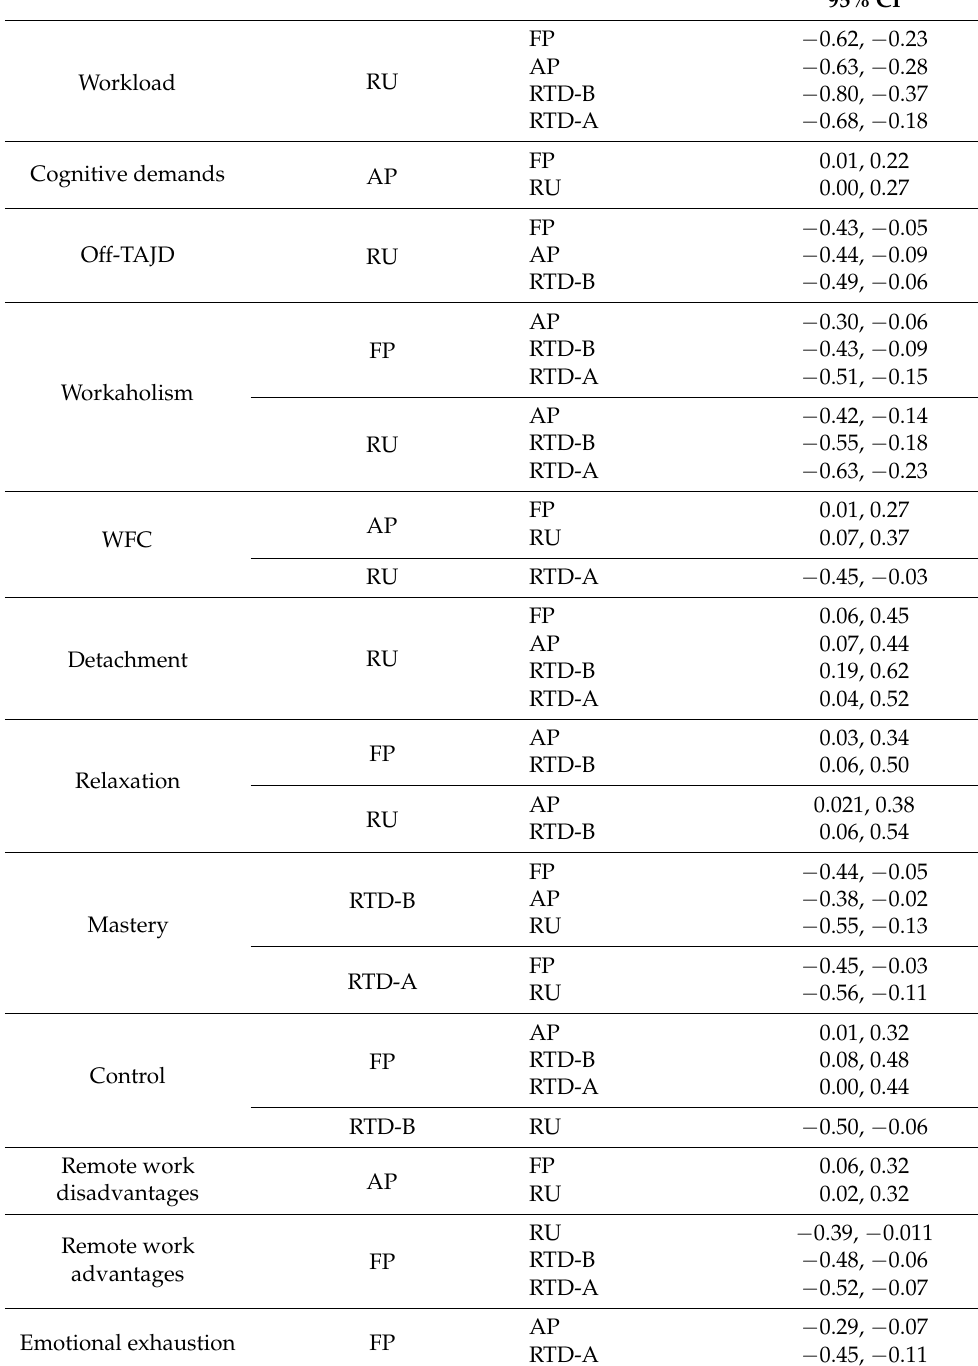
Table 6. ANOVA post hoc tests for the academics sample by